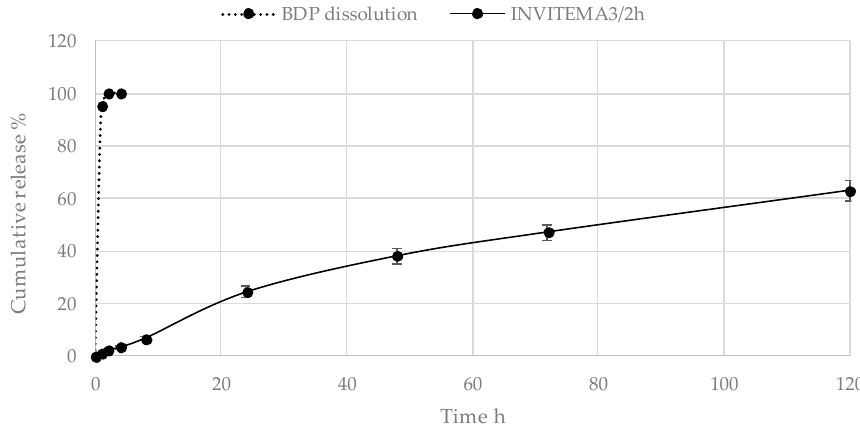
Figure 8. Drug release studies from INVITEMA3/2 h nanogrids, BPD dissolution curve is shown (sink conditions).